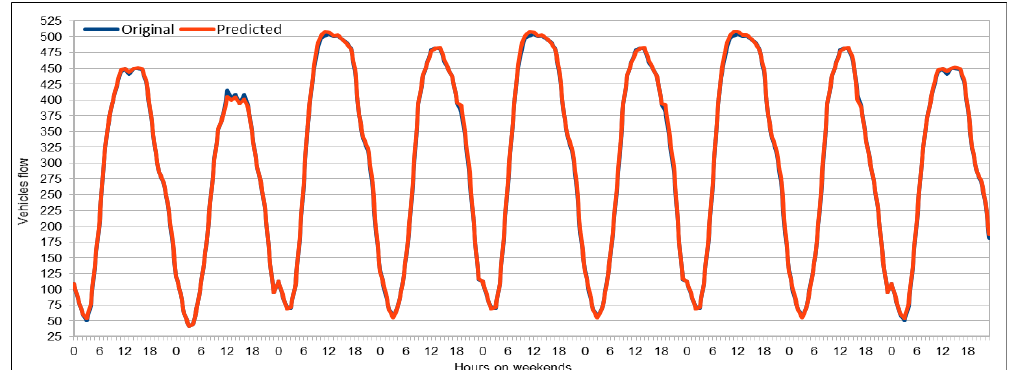
Figure 18. Comparison of original and predicted flow values on weekends.